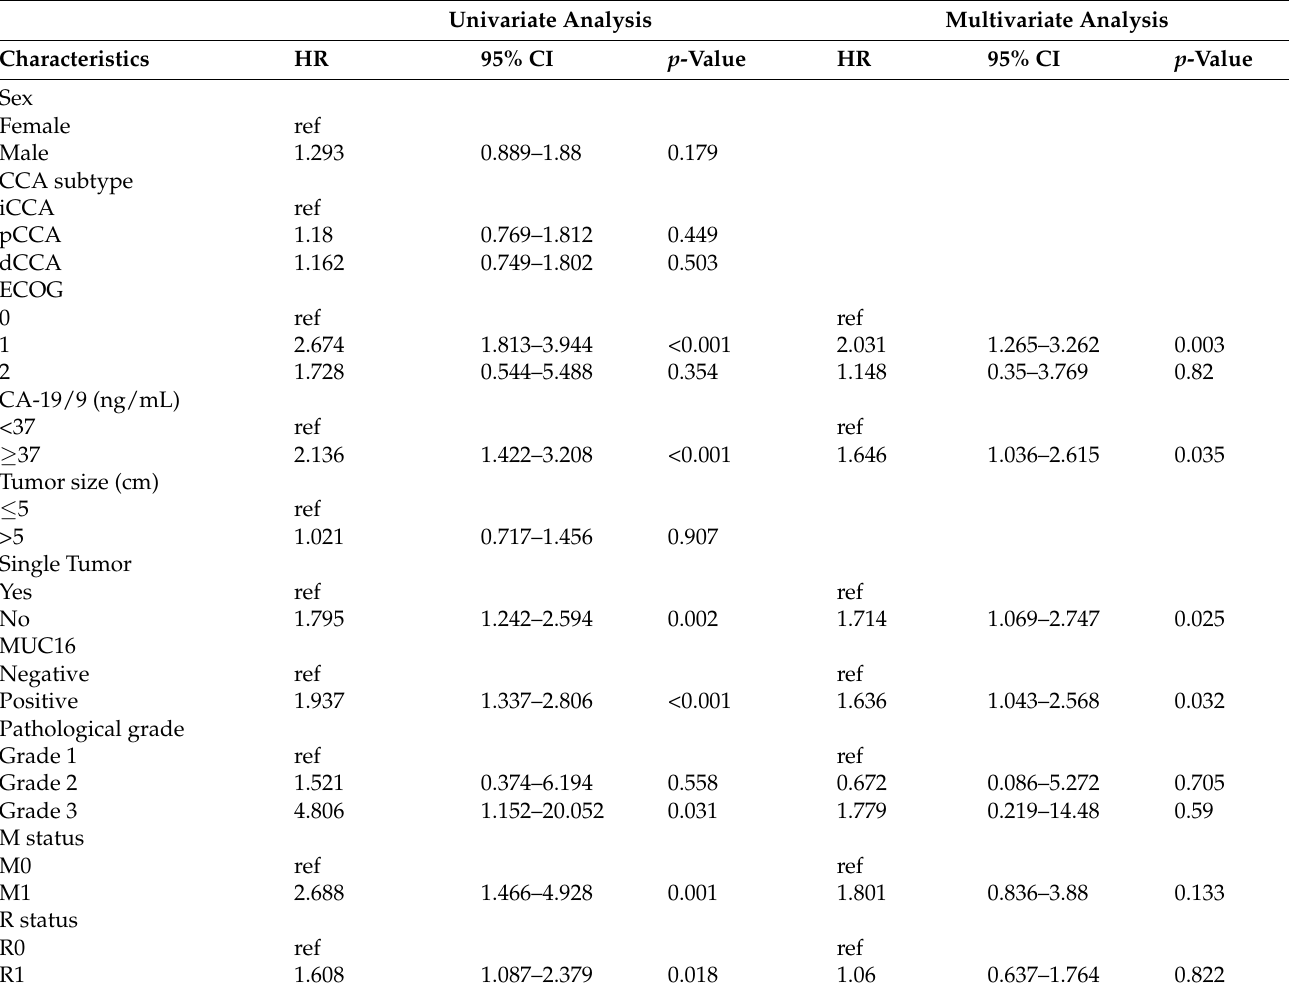
Table 2. Univariate and multivariate Cox regression analysis of OS in patients with CCA. Univariate Analysis Multivariate